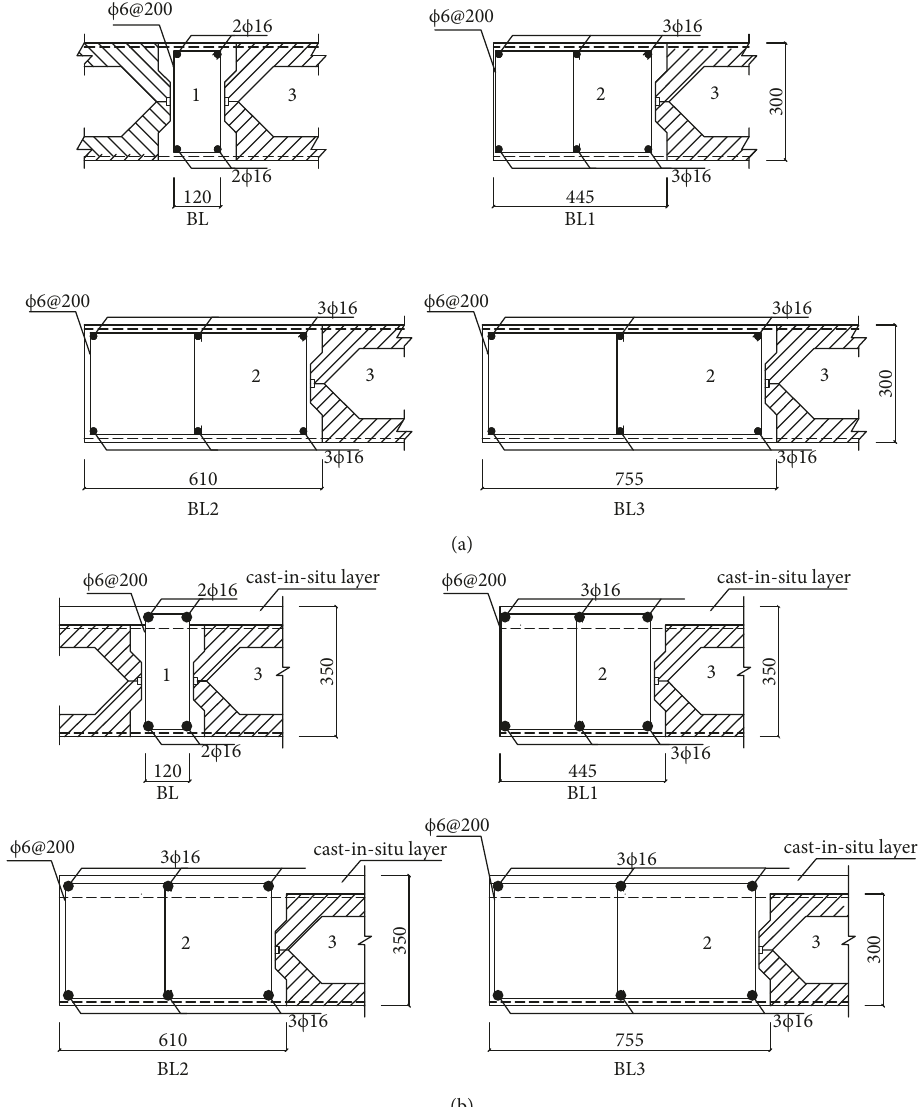
Figure 5: Specimen sketch map. (a) Open boxes. (b) Covered boxes. (1) Ribbed girder; (2) edge girder; (3) congruent